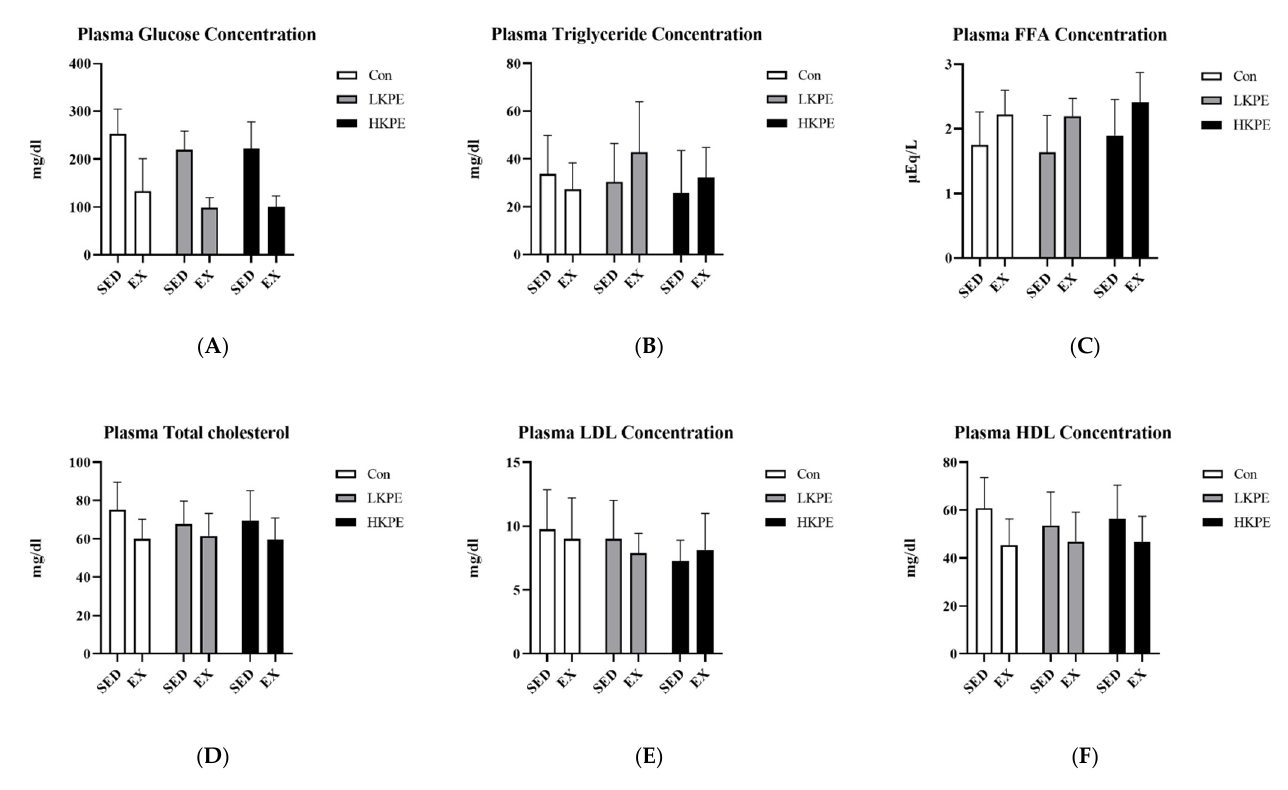
Figure 2. ( A ) Plasma glucose; ( B ) plasma triglyceride; ( C ) plasma FFA; ( D ) plasma total cholesterol; ( E ) plasma HDL; and ( F ) plasma LDL: concentrations immediately after exhaustion. FFA, free fatty acids; LDL, low-density lipoprotein cholesterol; HDL, high-density lipoprotein cholesterol; SED, sedentary; EX, exercise; Con, control; KPE, Kaempferia parviflora administration; ns, no significance observed.